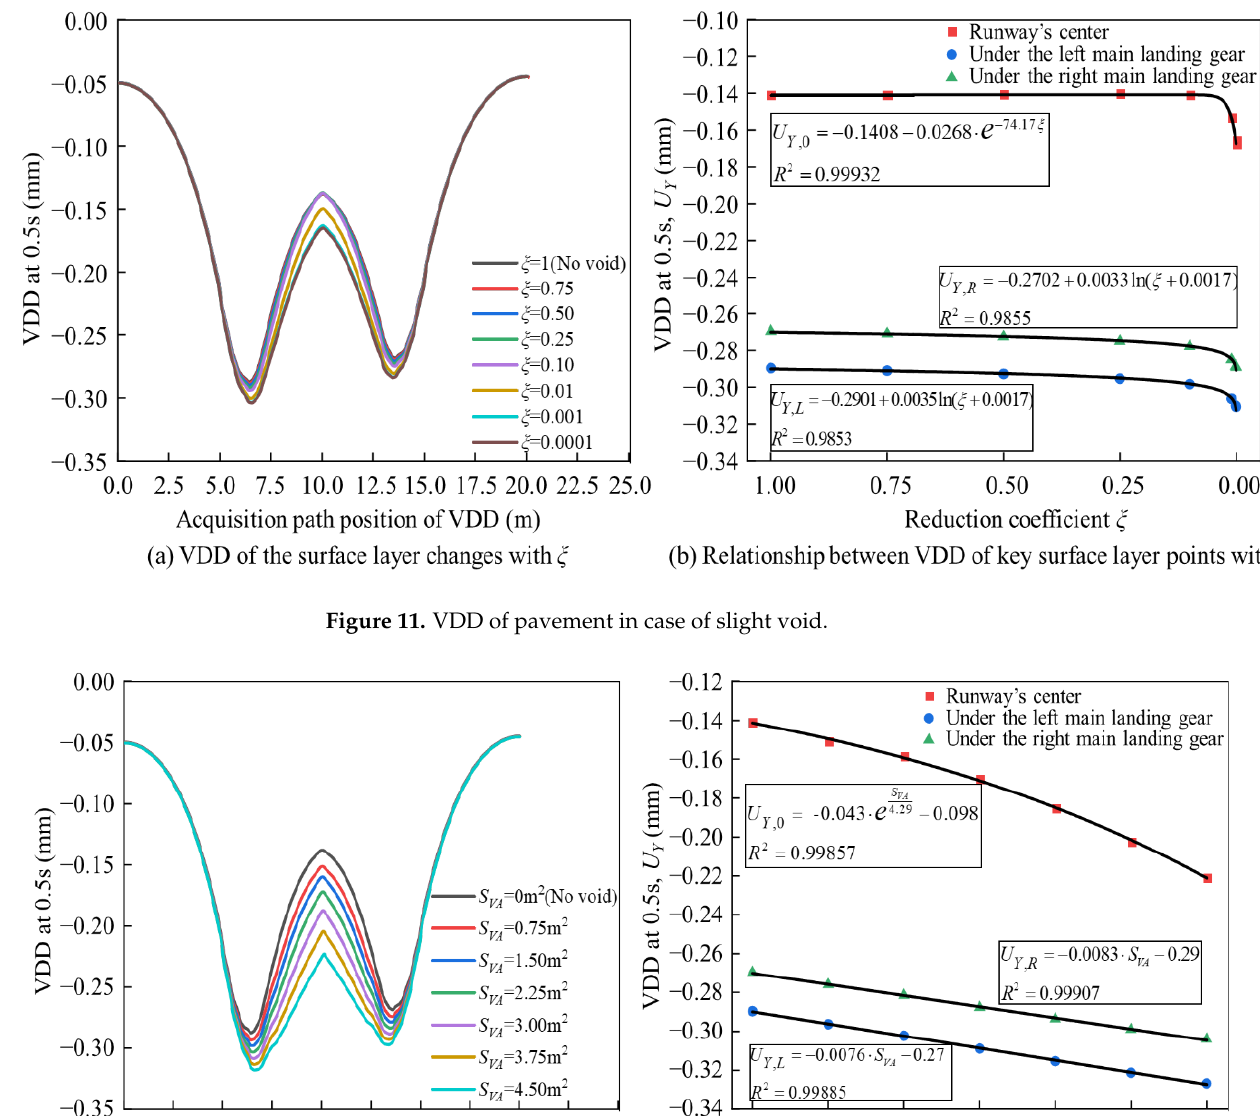
Figure 11. VDD of pavement in case of slight void.